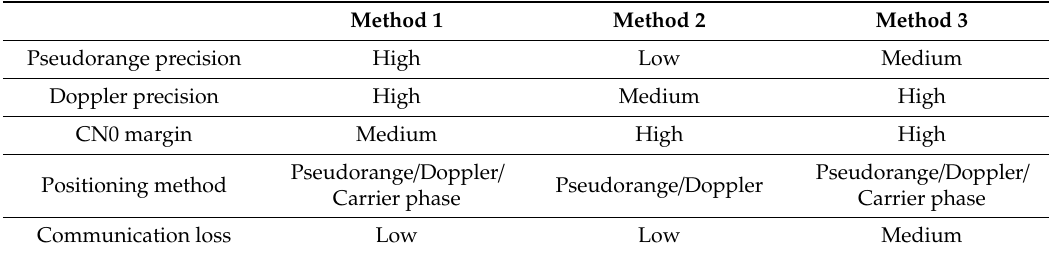
Table 1. Summary of the characteristics of three